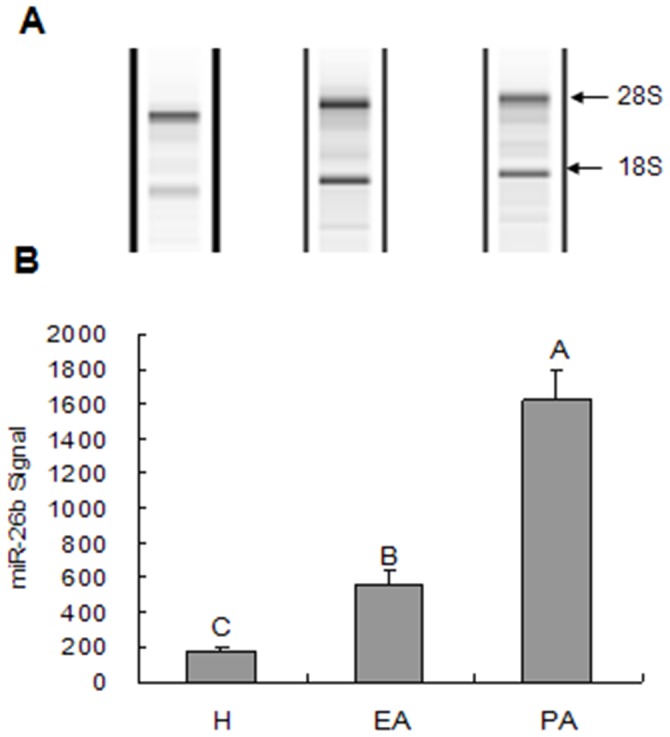
miR-26b expression during follicular atresia. miR-26b expression was detected by miRNA microarray assay.A, The quantity of RNA used in the microarray assay, and the integrity of 18 s and 28 s rRNA was checked. B, miR-26b signals were detected in healthy (H), early atretic (EA), and progressively atretic (PA) follicles. miR-26b expression was upregulated during porcine follicular atresia.